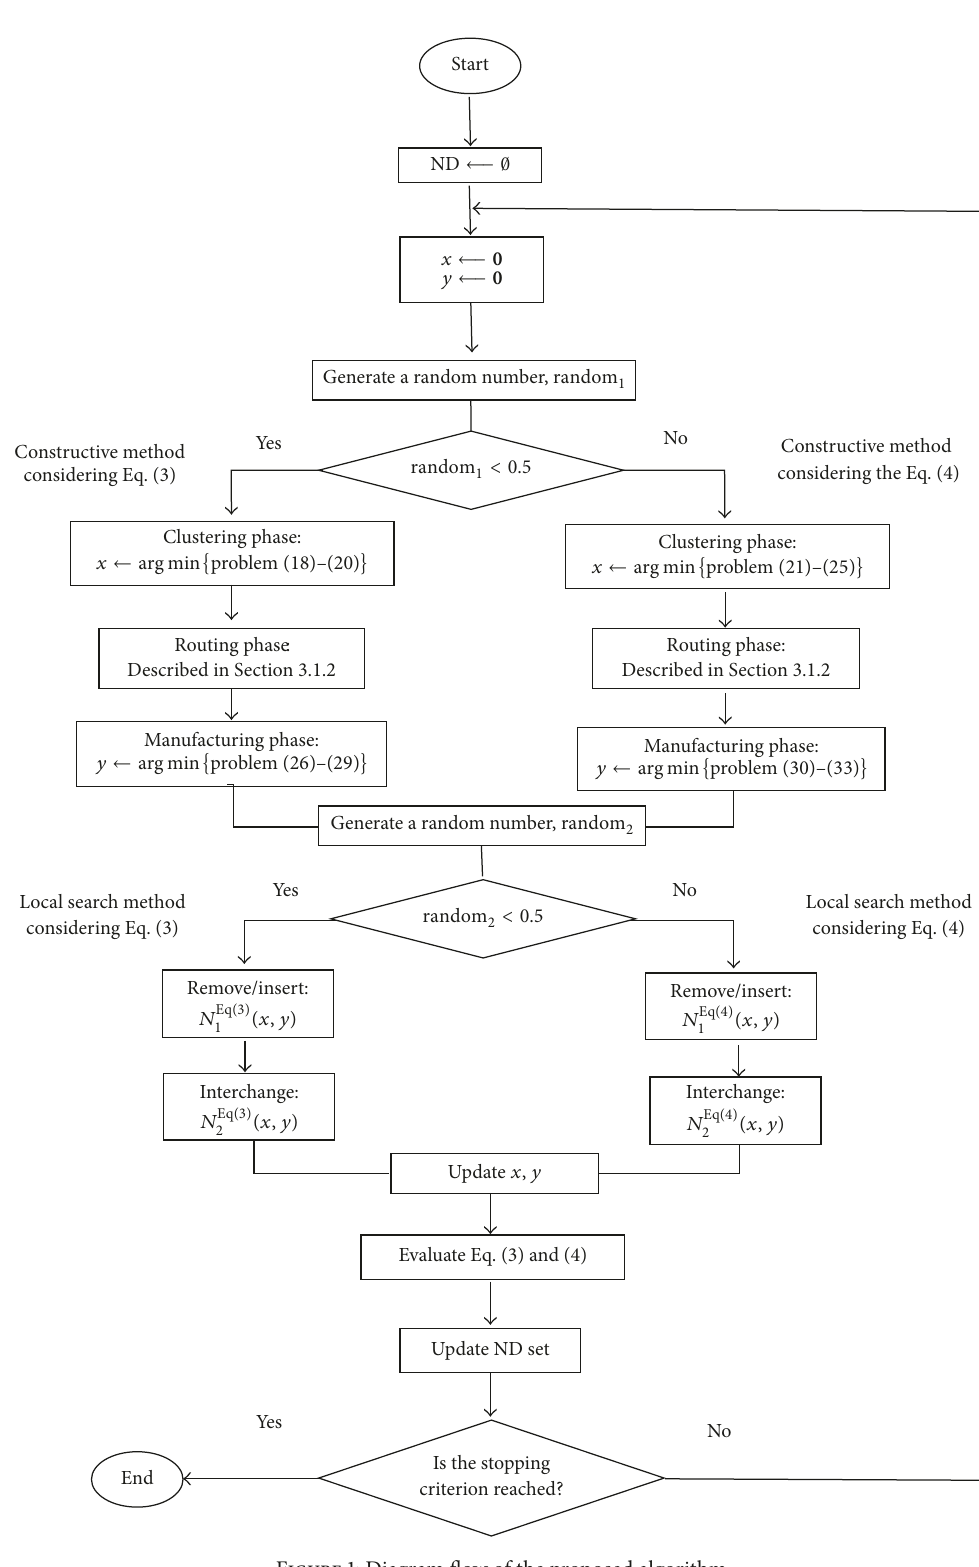
Figure 1: Diagram flow of the proposed